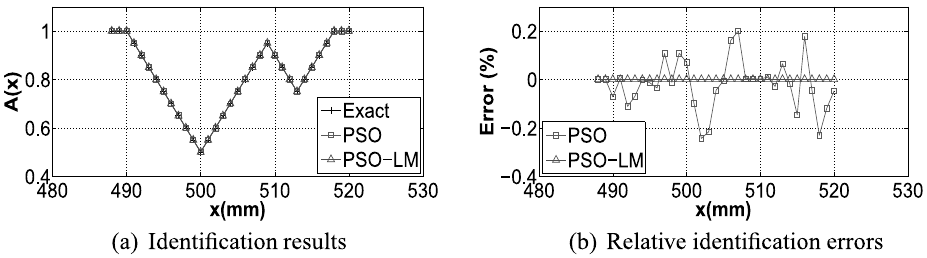
Fig. 8. Identi fi cation with noiseless data for Case 3 and the long rectangular pulse